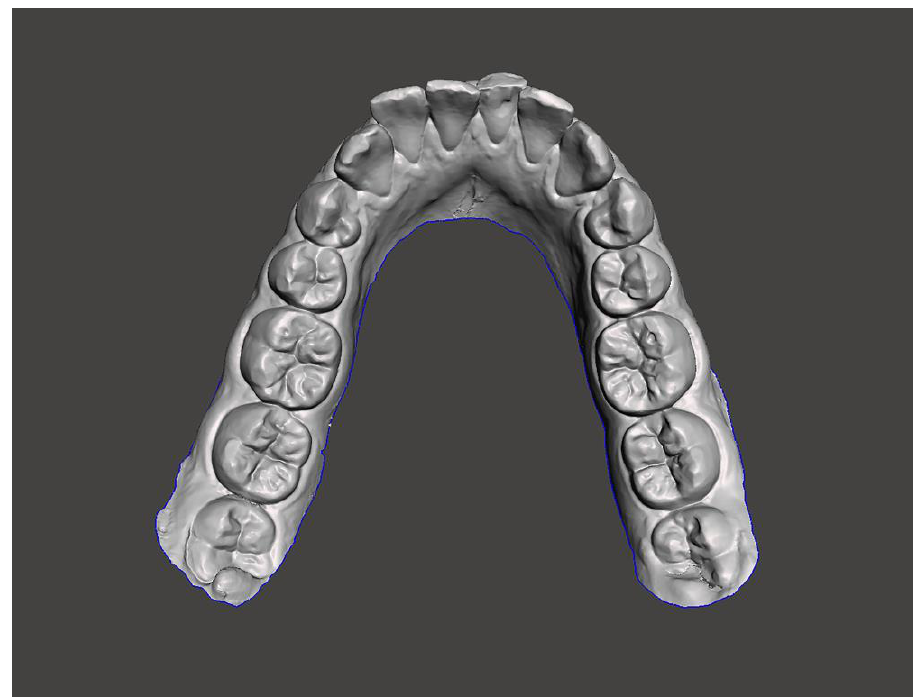
Figure 2. The digital model is uploaded onto the free-source software Mesh-Mixer (Autodesk, San Rafael, CA, USA) for detailing the anatomical dataset of interest.